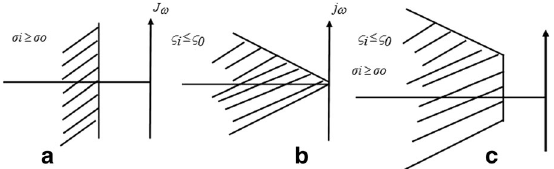
Fig. 2 Regions of closed loop eigenvalues for multi objective